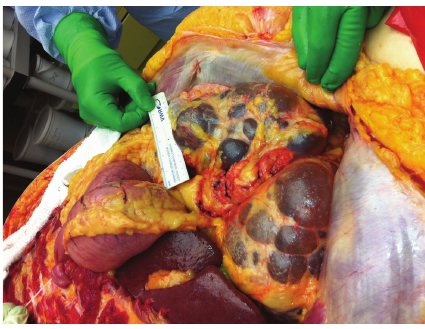
Figure 2: Macroscopic image of right kidney “in situ” showing bosselated cystic spaces.